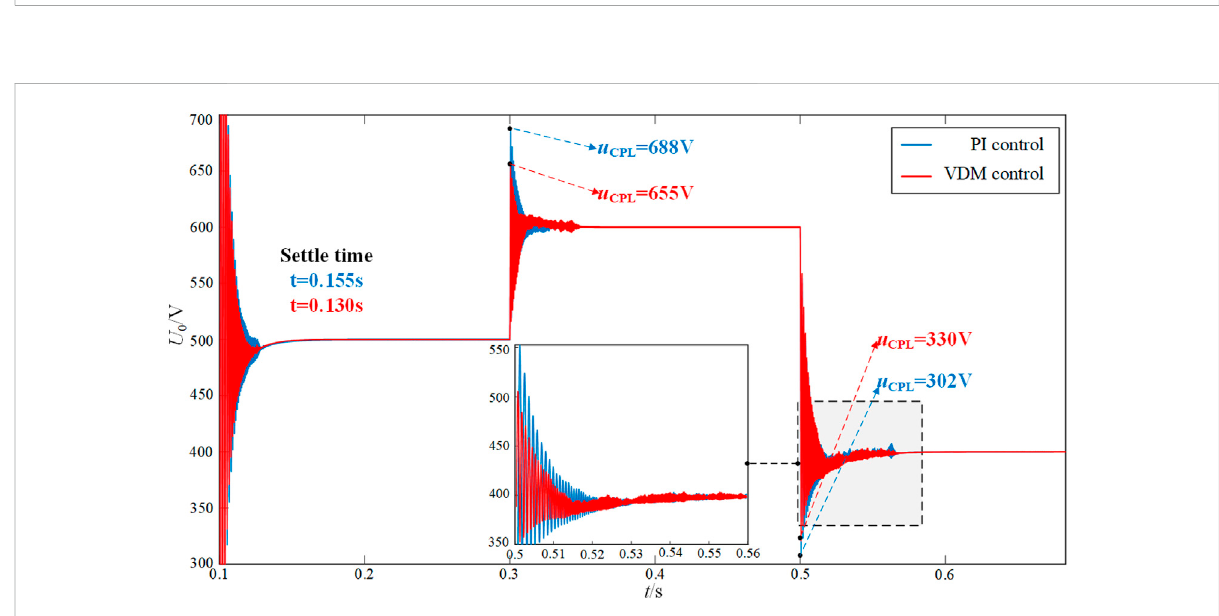
FIGURE 8 Comparison diagram of CPL voltage under CPL load step